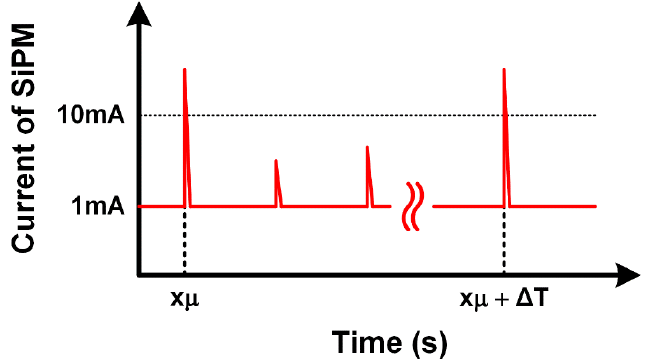
Figure 2. Load characteristics of an SiPM [5].